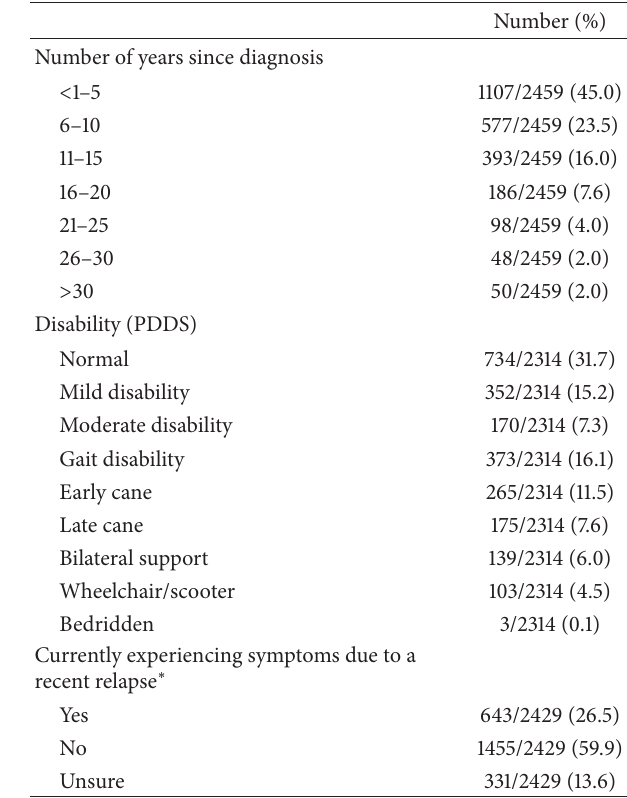
Table 4: Diagnostic characteristics and level of